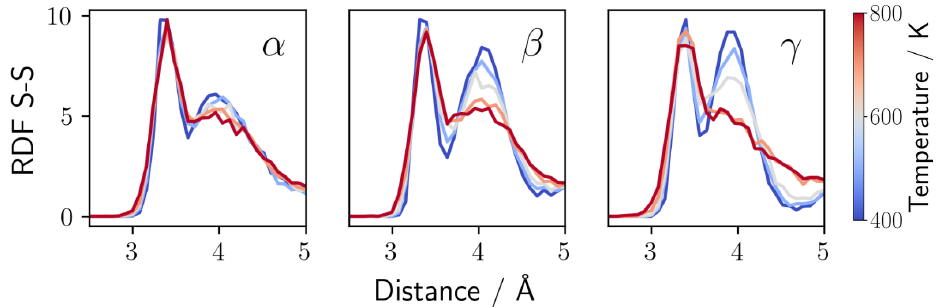
Figure 2. S-S radial distribution functions (RDFs) for MD snapshots of α -Li 3 PS 4 ( left panel), β -Li 3 PS 4 ( middle panel), and γ -Li 3 PS 4 ( right panel) at different temperatures. The disappearance of the peak at 4.3 Å, occurring for β and γ at 700K, corresponds to the phase transition to the α